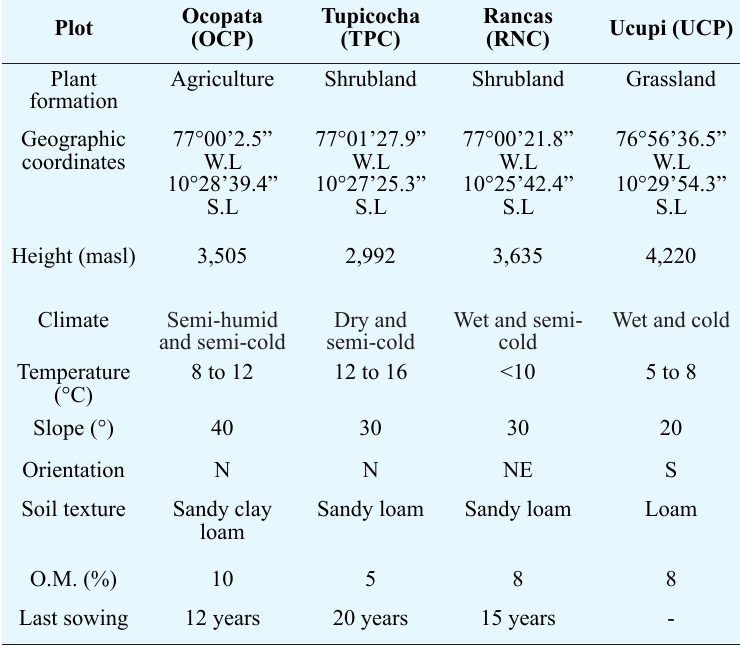
1. Main characteristics of the four agroecosystems evaluated in Cajatambo,